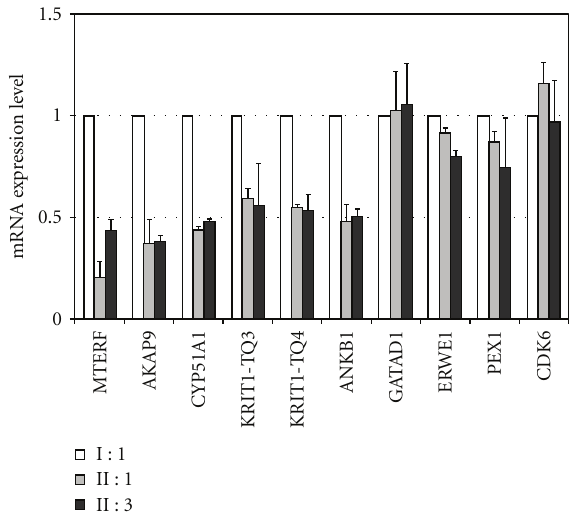
Figure 3: Copy number status Expression level analysis ( ± standard error mean) of genes mapping in the 7q21 chromosomal region determined by RT-QPCR was determined by RT-QPCR. Average relative mRNA expression genes level from two a ff ected members of CCM family (II: 1 and II:3) related to the normal ones as calibrator ( I:1) to GAPDH gene as reference.